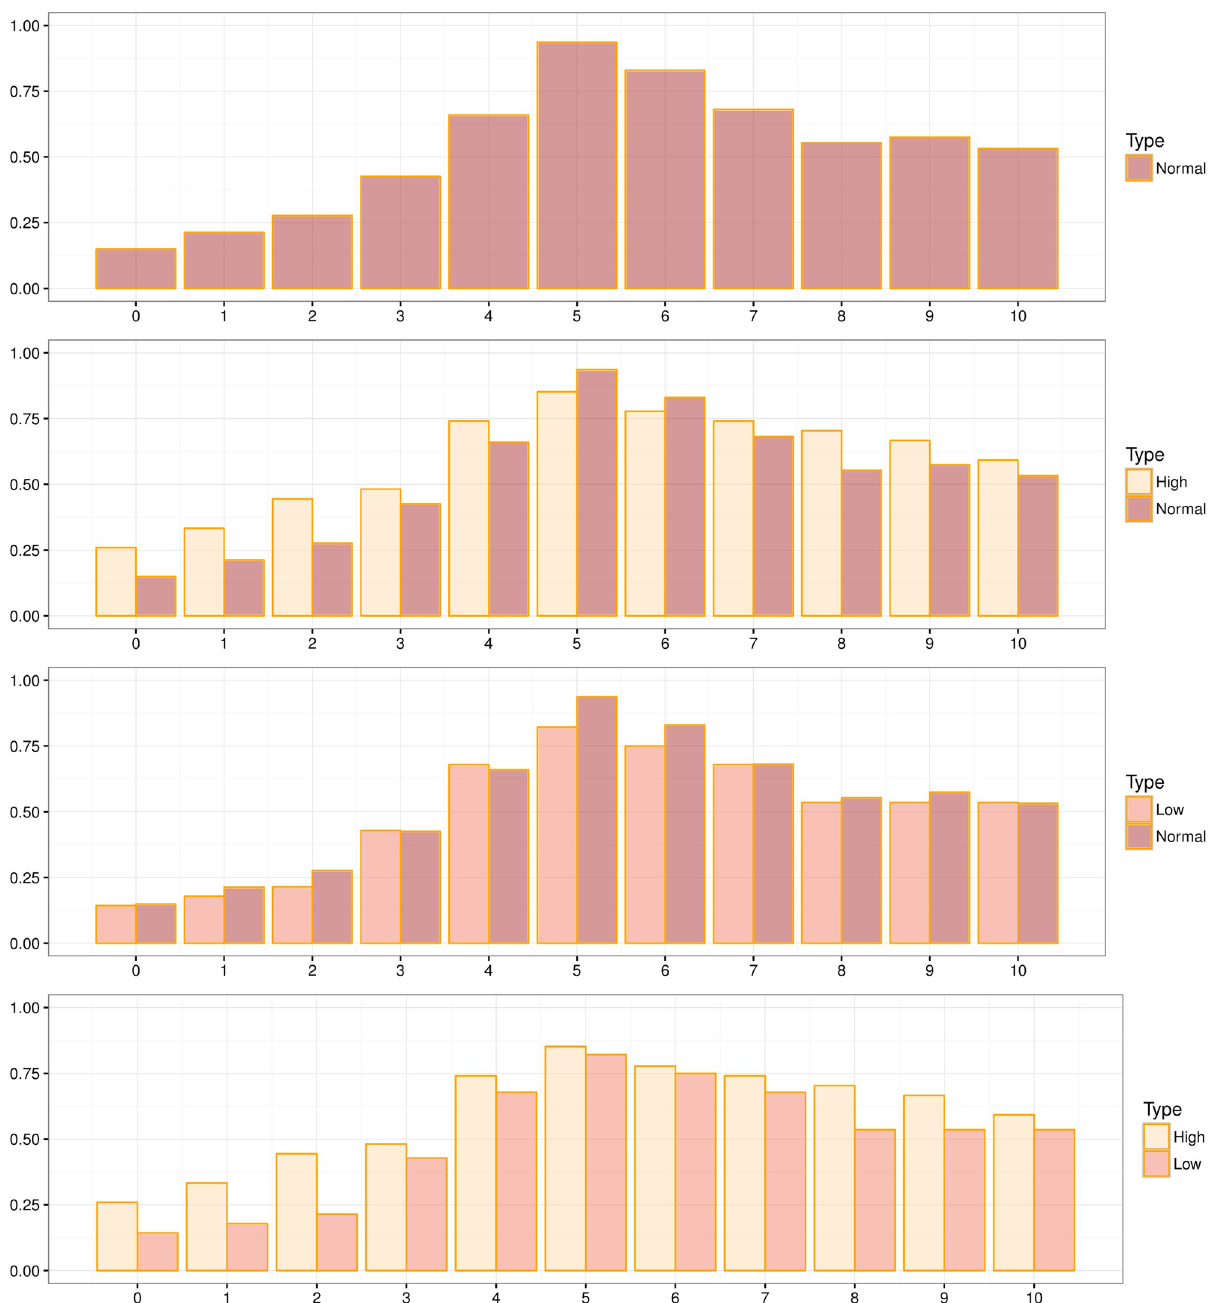
Fig 2. Acceptance rates for baseline treatments. For each graph, in the vertical axis we plot the percentage of acceptances, in the horizontal axis, the offer.